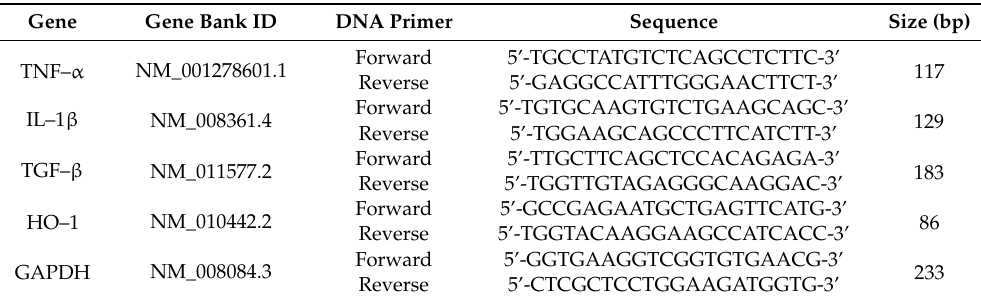
Table 1. Primers for proinflammatory (M1) and proregenerative (M2) marker